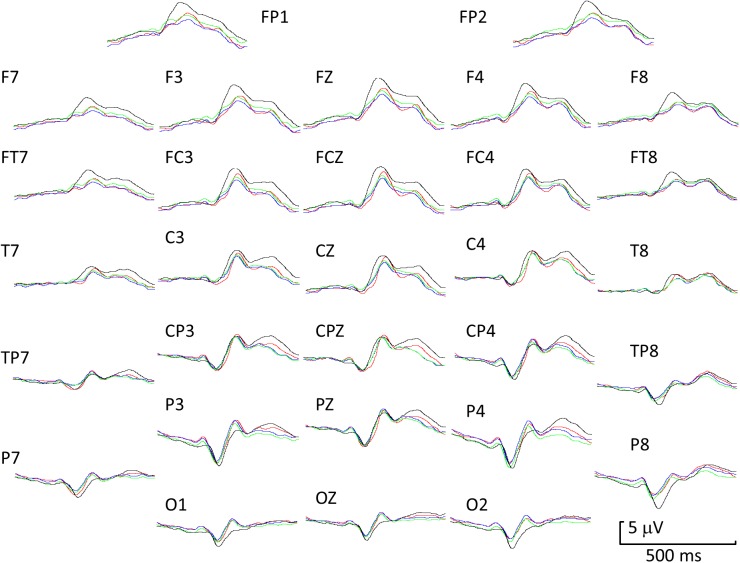
Grand mean ERP waveforms for the response to the transition in a face pair for all four experimental conditions: black = neutral-angry, red = neutral-magnified, green = angry-neutral, blue = magnified-neutral.Positive is upwards.